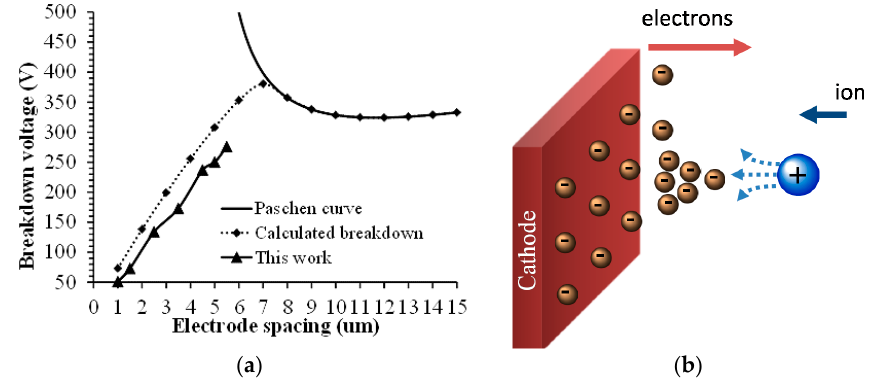
Figure 3. Modified Paschen curve for air. ( a ) The ion-assisted field ionization results in complete departure from the classical Paschen curve for small gap distances of less than 10 μ m in one atmosphere in most gases [24]. ( b ) Schematic representation of electron emission at cathode due to electric potential of an approaching ion [25].